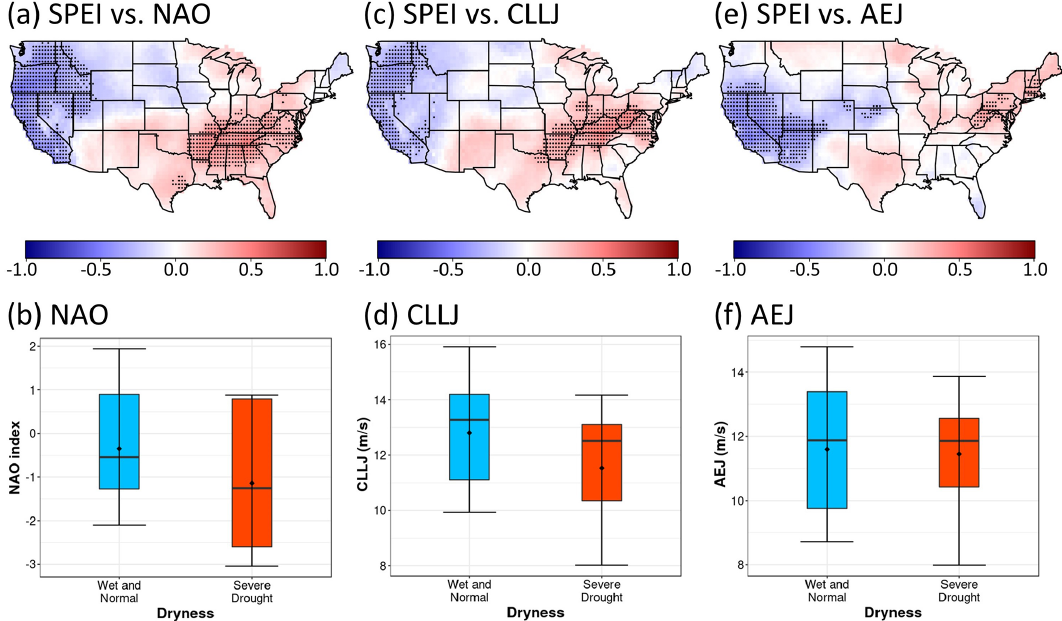
Figure 7. Map of the correlation coefficient between SPEI and the NAO (a) , CLLJ (c) , and AEJ (e) during 2000–2018 in JJA with black dots denoting the significant correlation at a 95% confidence level. The boxplots of the NAO (b) , CLLJ (d) , and AEJ (f) distributions under non-drought (wet and normal) and severe-drought